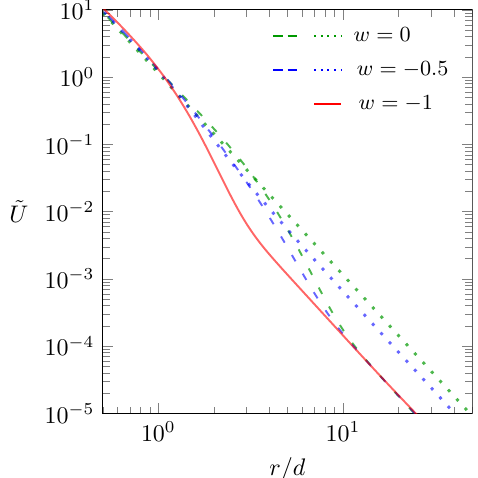
Figure 4. Scaled interaction energy ˜ U = ( 4 π(cid:101) 0 (cid:101) l d 3 / µ 1 µ 2 ) × U between two dipoles as function of the scaled separation r / d , calculated according to Equation (11). The green dotted line refers to w = 0 and l D → ∞ , the green dashed line to w = 0 and l D = d , the blue dotted line to w = − 0.5 and l D → ∞ , and the blue dashed line to w = − 0.5 and l D = d . The “metallic” case ( l D → 0) is shown by the red line, which is independent of w